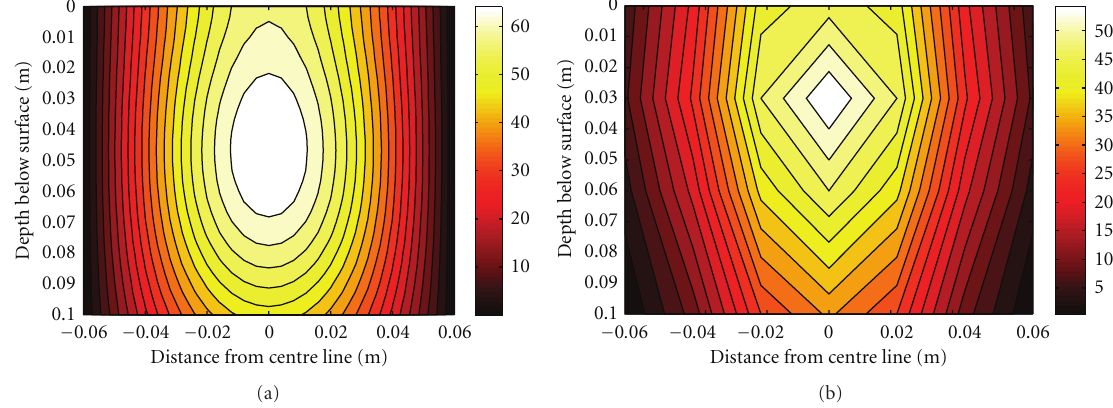
Figure 14: Comparison of expected soil temperature profile (a) with measured soil temperature profile (b) for the 750 W prototype microwave unit after 150 seconds of heating (note: the temperature scales is in ◦ C).